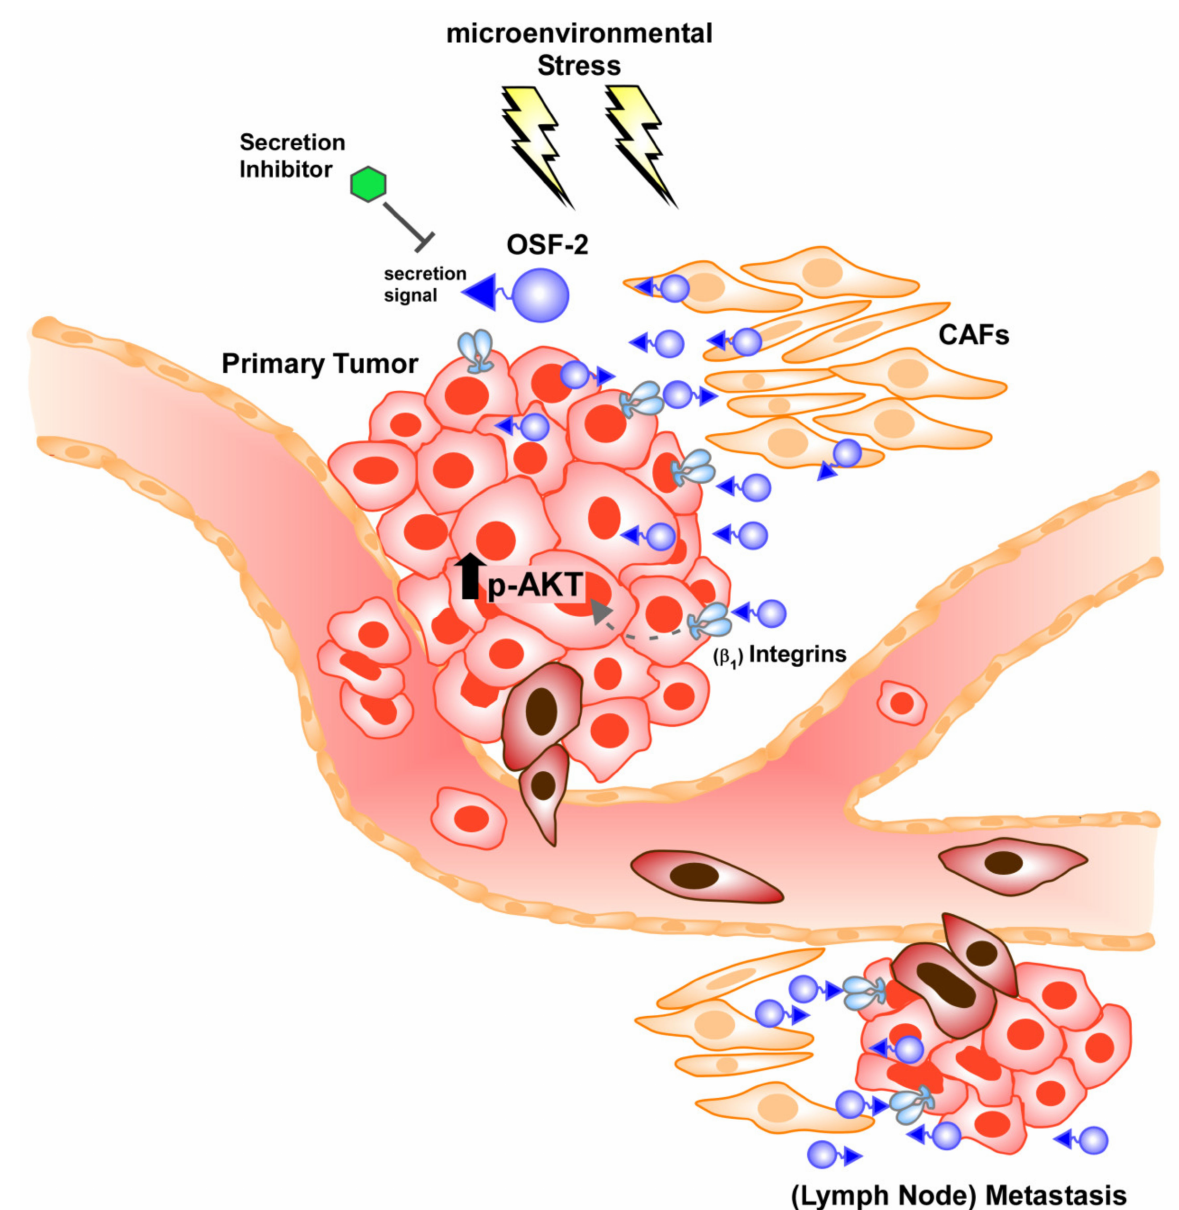
Figure 9. Proposed OSF-2 function in promoting (lymph node) metastases by regulating the tumor microenvironment and cellular survival. OSF-2 is overexpressed in tumor cells, as well as in cancer- associated fibroblasts (CAFs) at the primary tumor and lymph node metastatic sites in HNC. Though, it is likely that these mechanisms are also relevant for distant site metastases in other cancer types. Due to the conserved N-terminal secretion signal, OSF-2 seems to execute its tumor-promoting functions not mainly intracellularly, but extracellularly in the tumor microenvironment. Here, secretion inhibitors could be therapeutically relevant. OSF-2 modulates the tumor microenvironment by integrin-dependent activation of Akt/PKB pathways and downstream signaling, particularly critical under stress